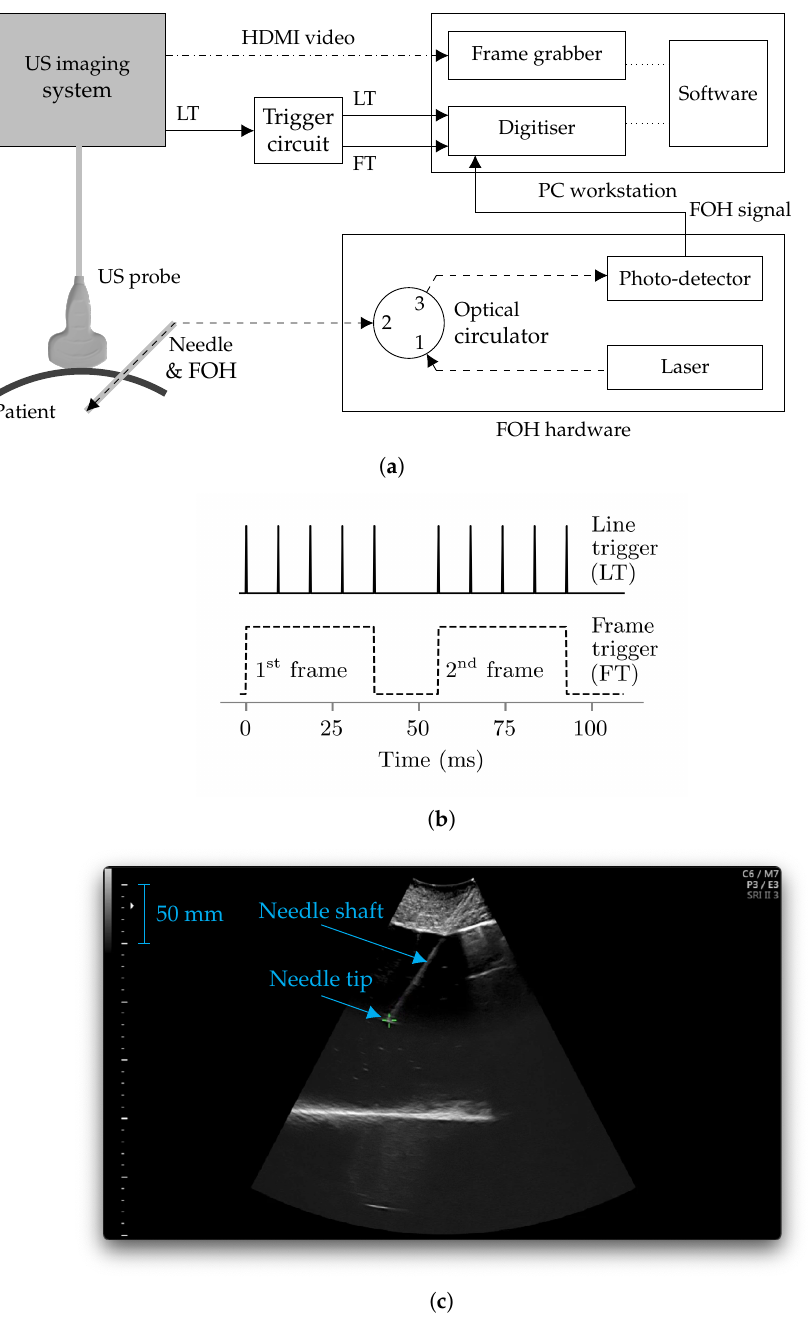
Figure 1. ( a ) Schematic diagram of the UNT system with the US imaging system. Solid lines represent analogue voltage signal paths, dashed lines indicate optical signal paths and the dash-dot line represents an HDMI cable. The dotted lines internal to the PC workstation represent PCIe interfaces. “LT” and “FT” respectively represent “line trigger” and “frame trigger”. Plots of the line trigger and frame trigger signals are shown in ( b ), where for visibility, there are only 5 US transmissions per frame. ( c ) An annotated screenshot of the real-time display provided to the clinician during a procedure, which indicates the tracked position of the needle tip with a green cross-hair. Blue text and arrows are additional annotations not featured in the software